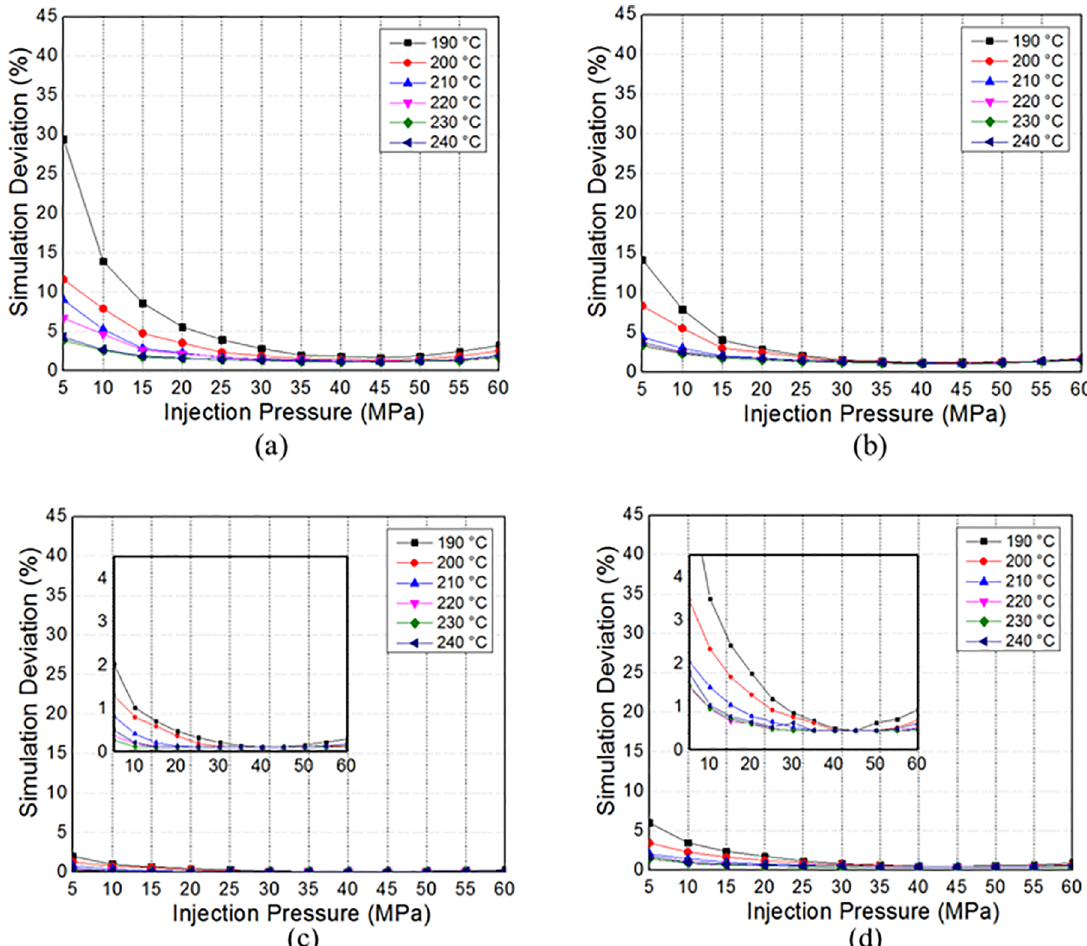
Figure 12. Simulation deviations considering the modified mold (with venting system) varying the injection pressure and temperature for distinct situations of mold temperatures: a) 20 ºC; b) 30 ºC; c) 40 ºC; d) 50 ºC.